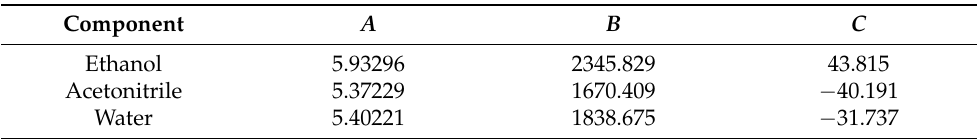
numbers, the unit of obtained vapor pressure is